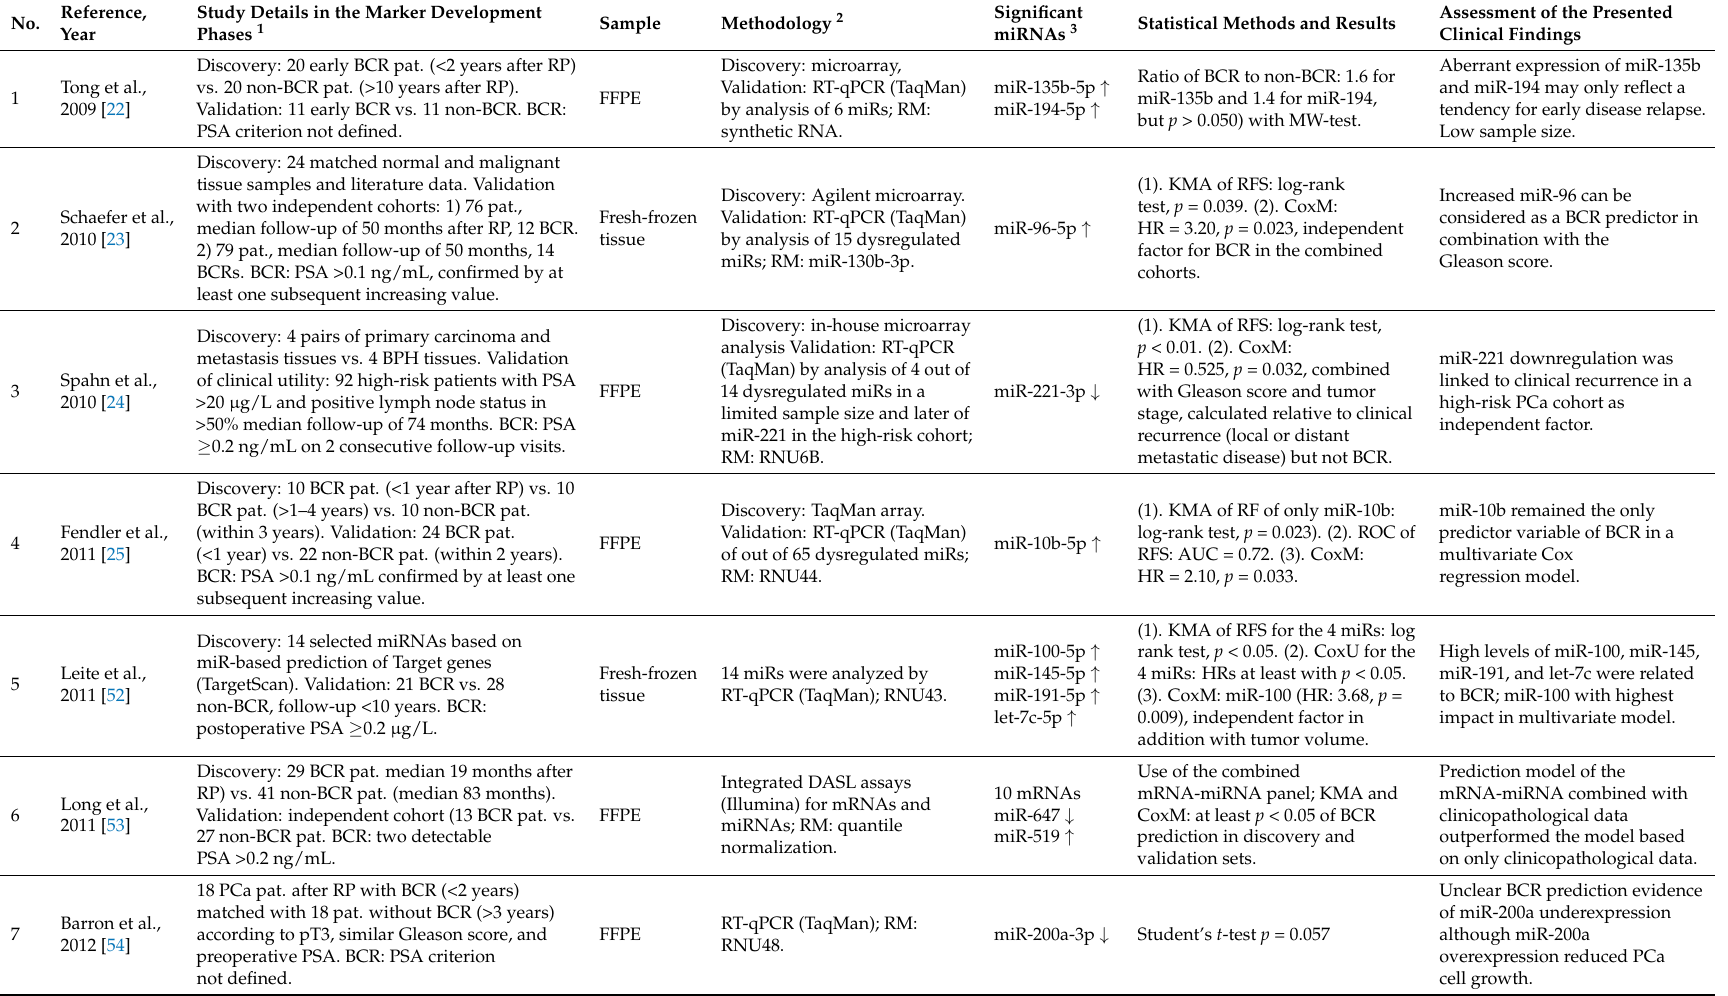
Table 3. Studies regarding tissue miRNAs as predictive markers for biochemical recurrence in prostate cancer after radical